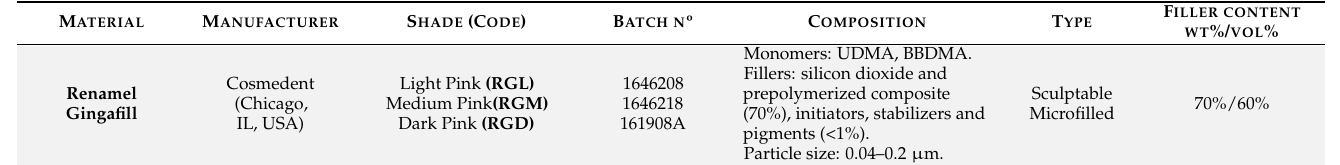
Table 1. Information on the gingiva-colored resin-based composites evaluated in the study. All resin-based composites data were provided by manufacturers.